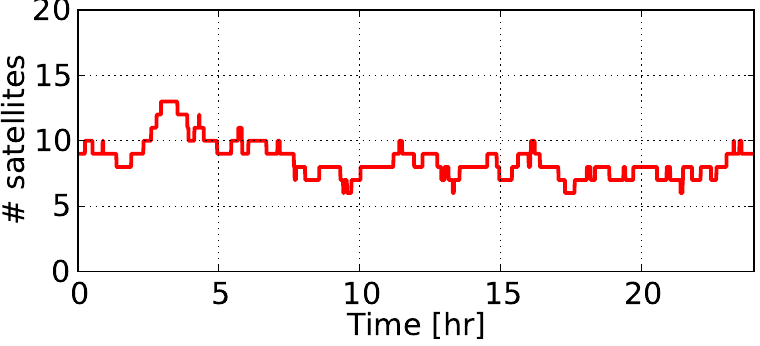
Figure 3. Number of GPS satellites tracked in network #1 during 16 February